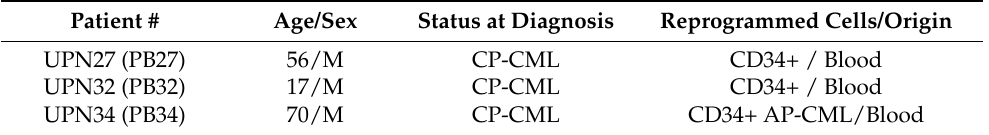
Table 1. Clinical characteristics of the patients. Patient # Age/Sex Status at Diagnosis Reprogrammed Cells/Origin UPN27 (PB27) 56/M CP-CML CD34+ / Blood UPN32 (PB32) 17/M CP-CML CD34+ / Blood UPN34 (PB34) 70/M CP-CML CD34+ AP-CML/Blood (CP-CML: Chronic Phase CML; PB: Peripheral